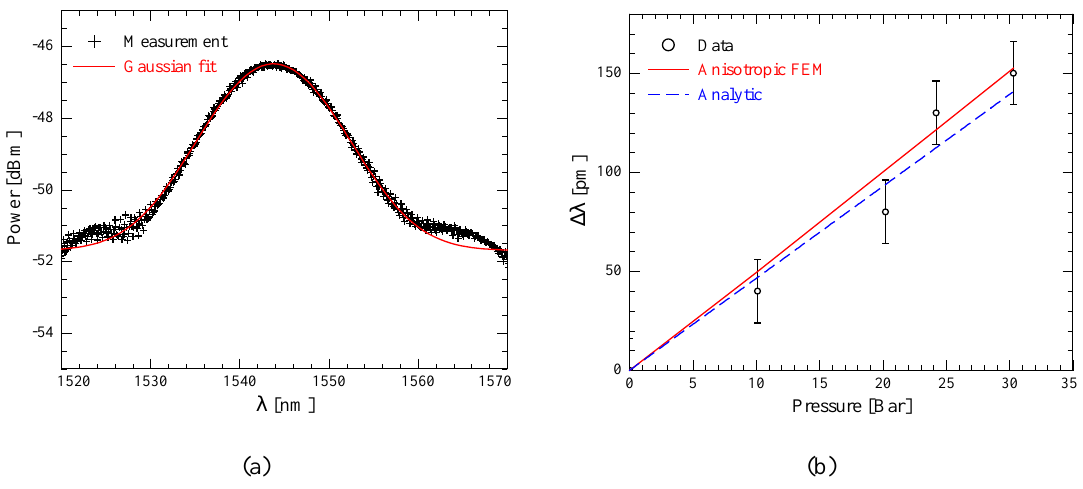
Figure 4. (a) Measured reflection spectrum from the a Bragg grating sensor with a Bragg wavelength of 1,543.8 nm; the full red curve is a Gaussian fit to the measured data with a standard deviation of the center wavelength of 16 pm. (b) The measured absolute Bragg wavelength shift as function of pressure for a 400 µ m radius membrane with the grating positioned at 200 µ m from the center. The error bars equal ± 16 pm, i.e. , one standard deviation, and thus the sensitivity of ∼ 4 . 8 pm/bar (4.8 × 10 − 5 pm/Pa) is found to be easily within two standard deviations of both FEM simulation (full curve) and analytical results (dashed